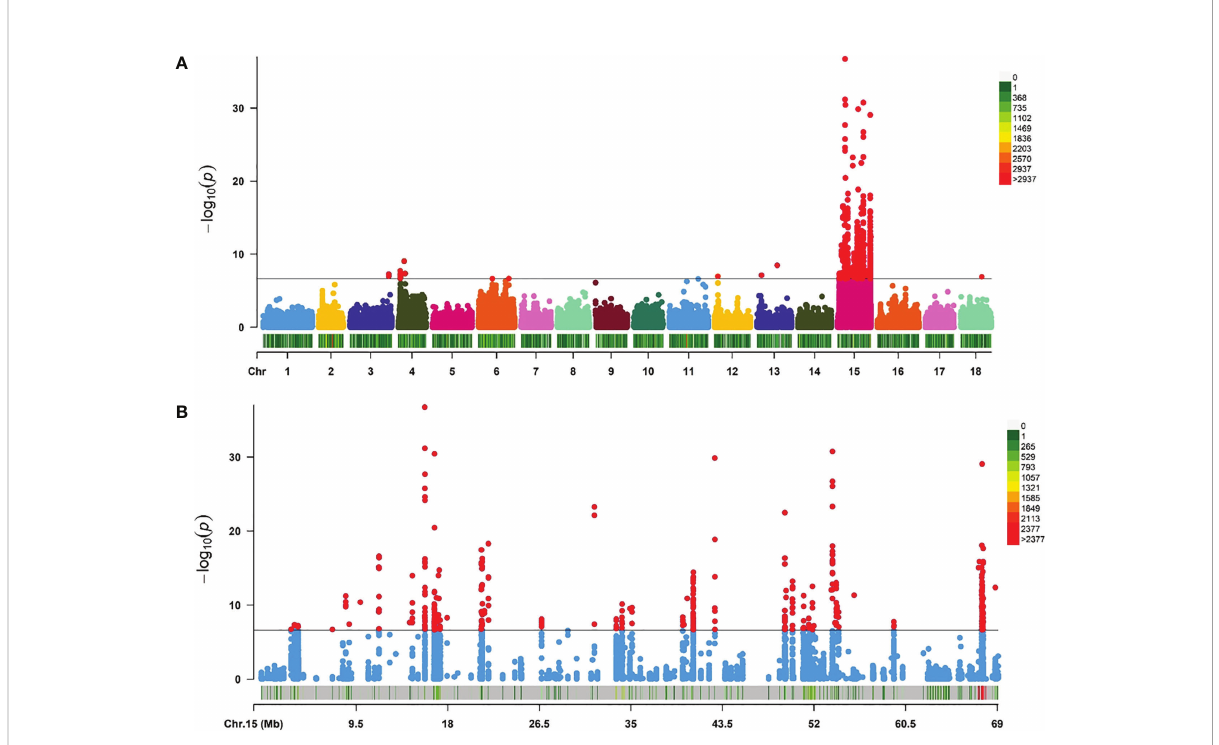
FIGURE 4 Manhattan plots of genome-wide association study (GWAS) analysis. (A) GWAS for mantle markings with 603,067 single-nucleotide polymorphisms (SNPs) in three-way cross abalone ( p < 2.32E – 07). (B) GWAS for mantle markings with 10,116 SNPs on Chromosomes 15 in three-way cross abalone ( p < 2.32E – 07).